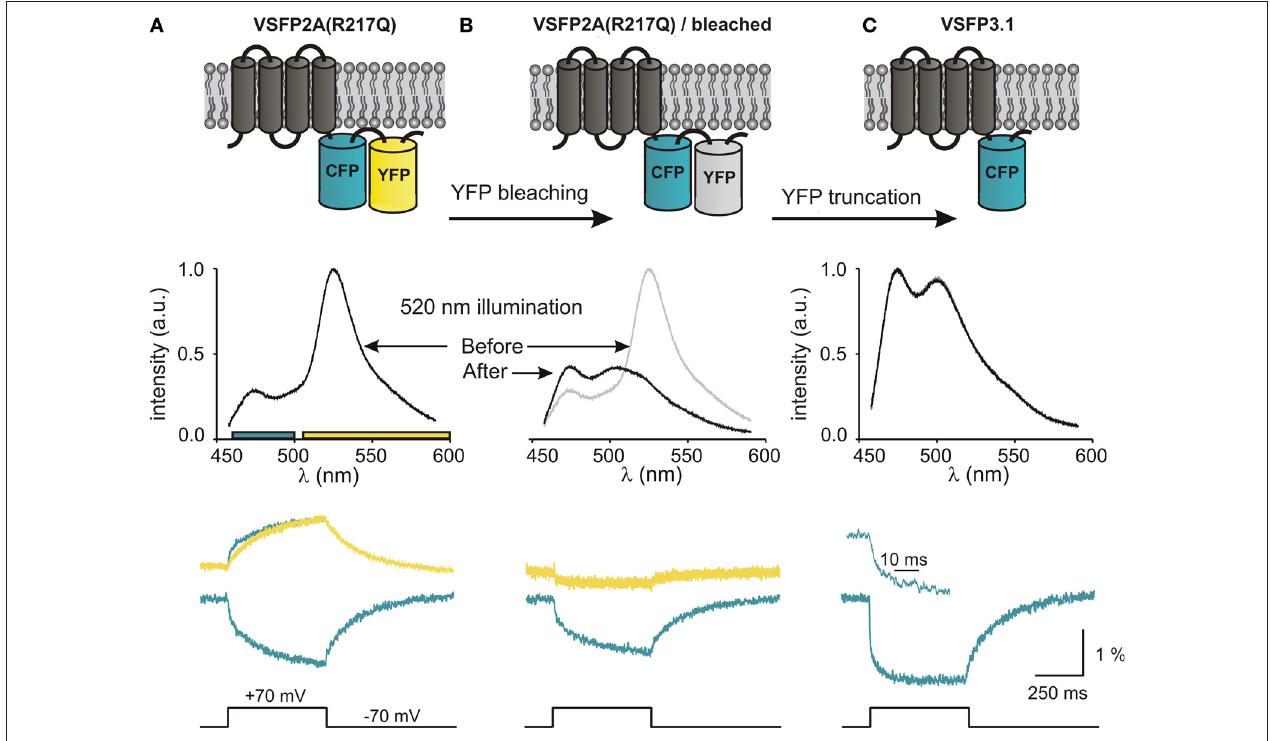
FIGURE 5 | Development of third generation voltage-sensitive fl uorescent proteins. The membrane topology of VSFP2A(R217Q) (A) , VSFP2A(R217Q) after acceptor photobleaching (B) and VSFP3.1 (C) is illustrated in top panels. Emission spectra recorded for each constructs using 440-nm excitation light are shown below. The lower panel shows the depolarization-induced